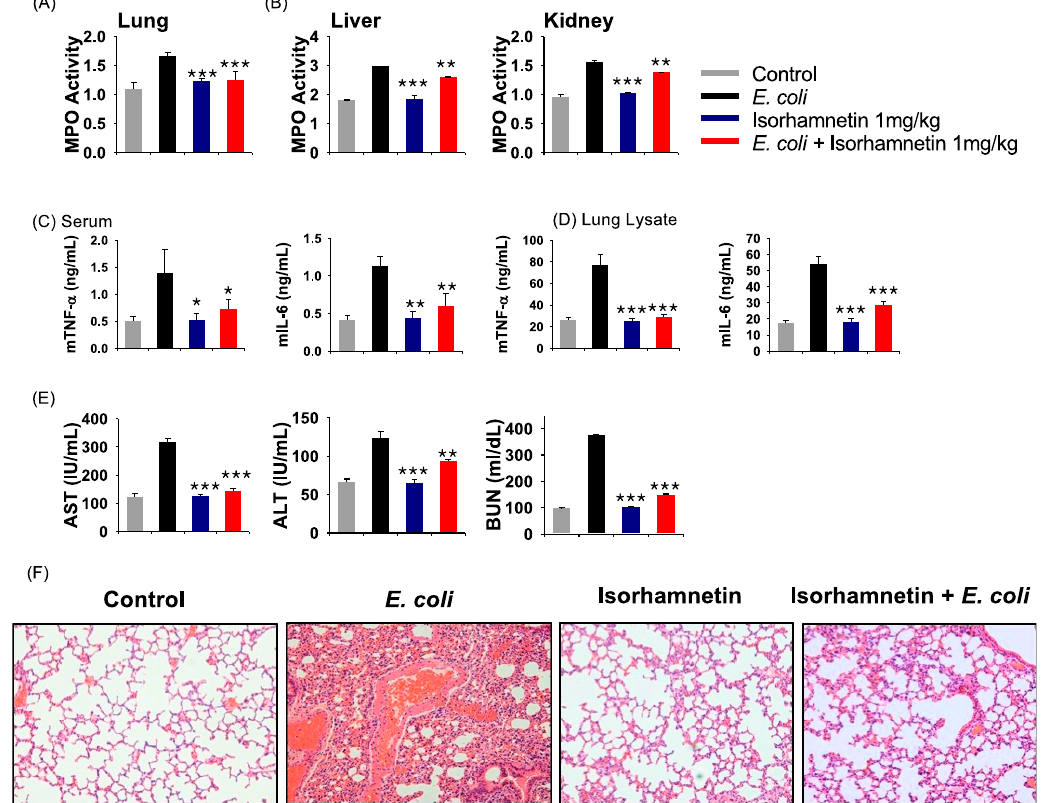
Figure 3. In vivo anti-inflammatory and toxicity evaluation of isorhamnetin. ( A,B ) Examination of myeloperoxidase (MPO) activity in lung, liver and kidney. ( C,D ) Production of cytokines (TNF- α , IL-6) in the sera and lung lysates. ( E ) Aspartate aminotransferase (AST), alanine amino transferase (ALT) and blood urea nitrogen (BUN) levels in the serum. (F) Hematoxylin and eosin staining of the lung tissue. Data are presented as the means ± SEM. * p < 0.05; ** p < 0.01; and *** p < 0.001 compared to the E. coli group.